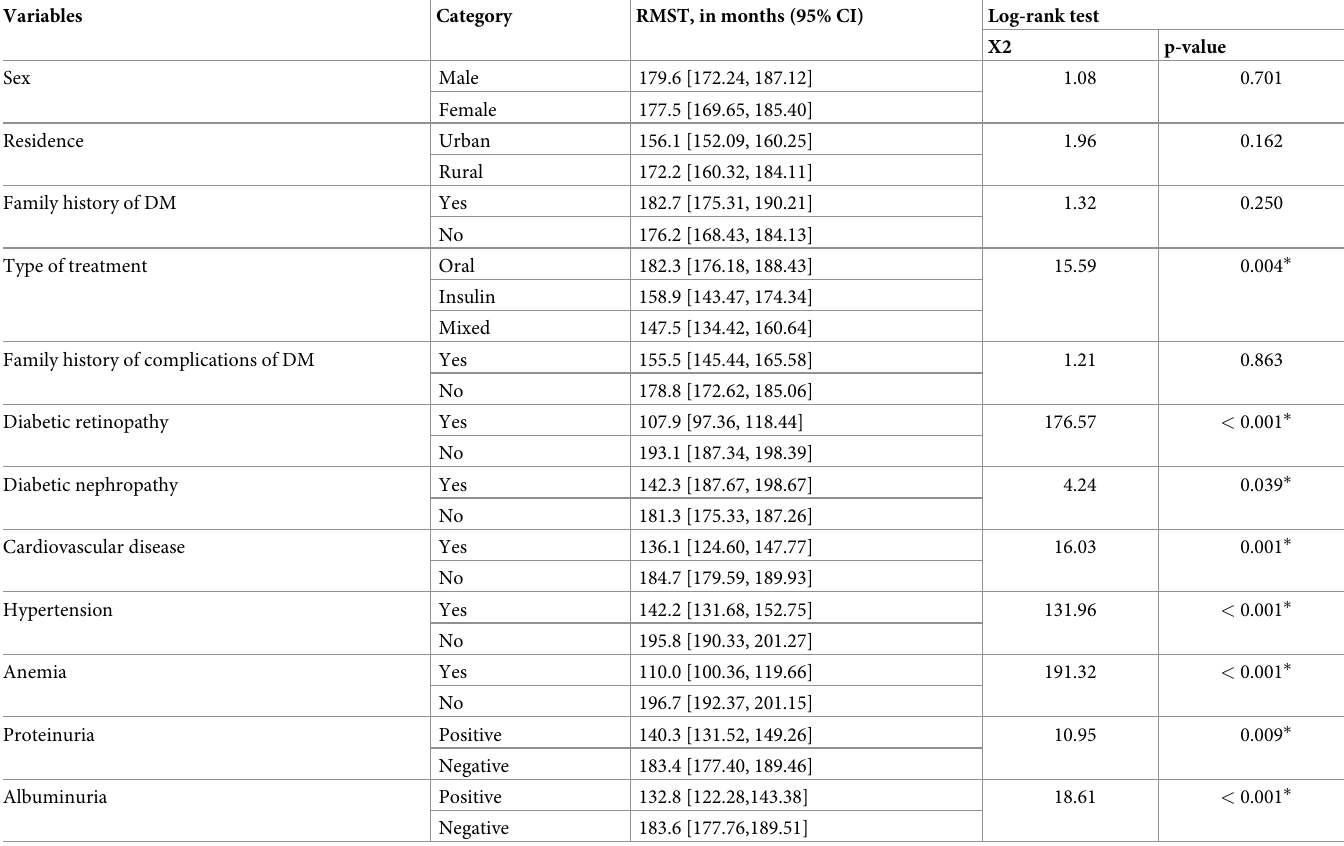
* indicates the significantly associated categorical variables at p < 0.05 in the Log-rank test for equality of survivor functions with a 95% confidence level.